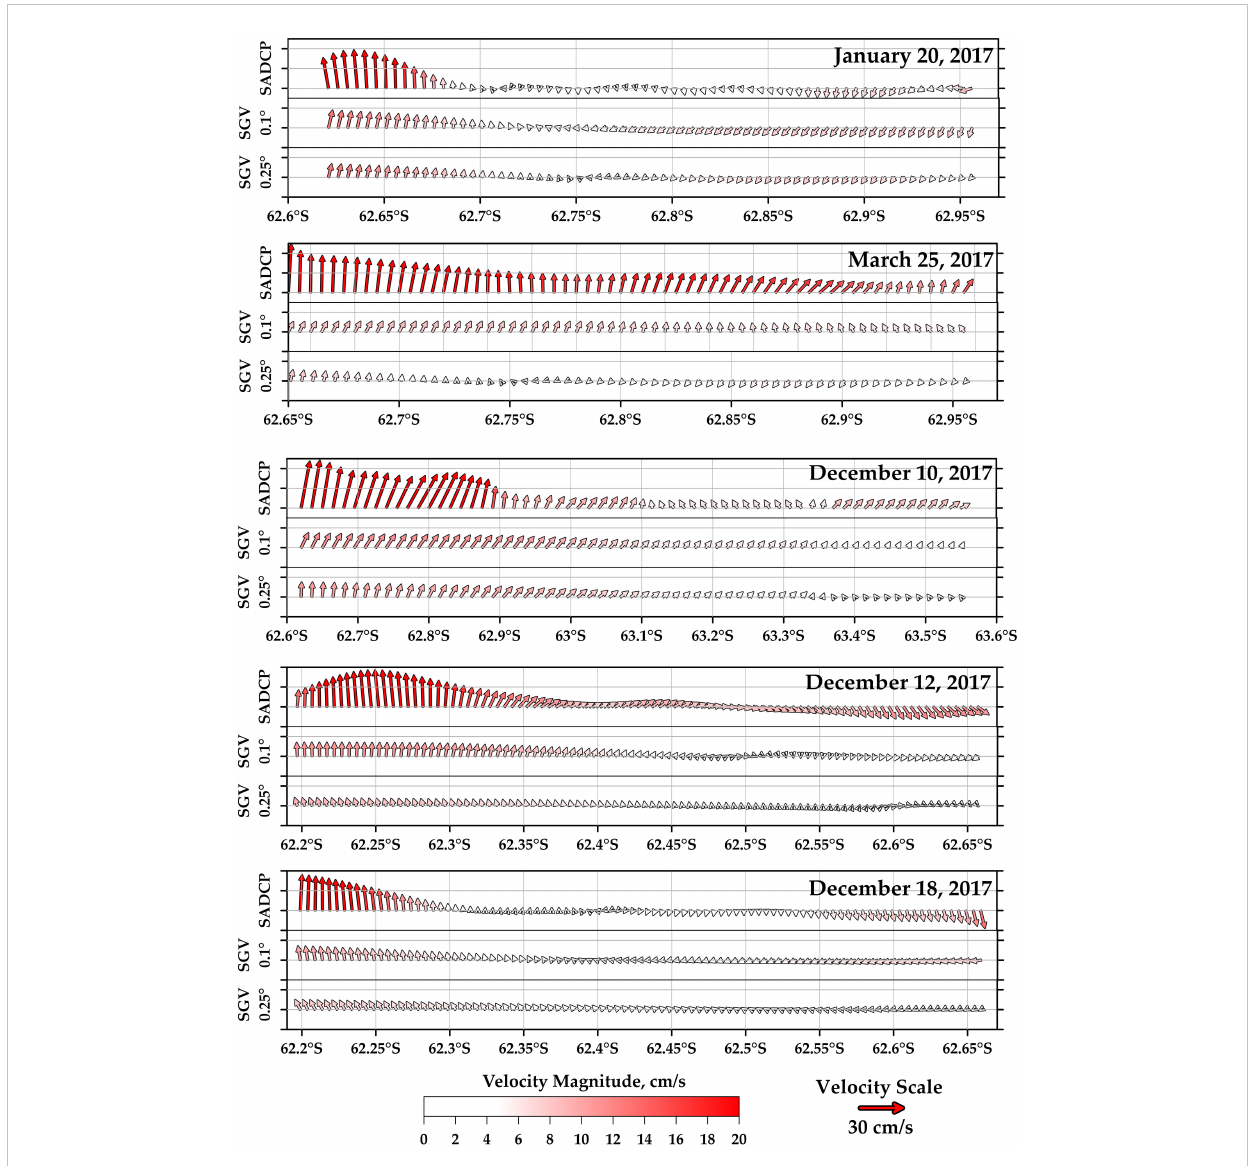
FIGURE 13 Comparison between SADCP velocities averaged over the upper 700 m and sea-surface geostrophic velocities derived from altimetry of 0.1° and 0.25° resolution along fi ve sections in the Brans fi eld